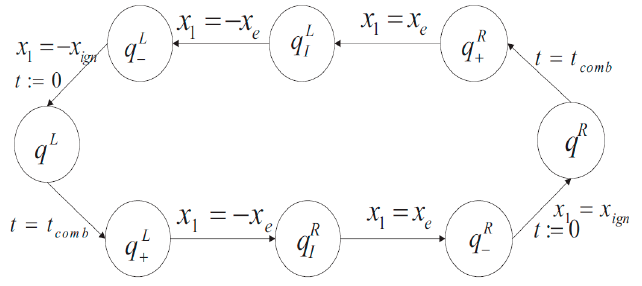
Figure 26. Hybrid automation of FPLG [54].